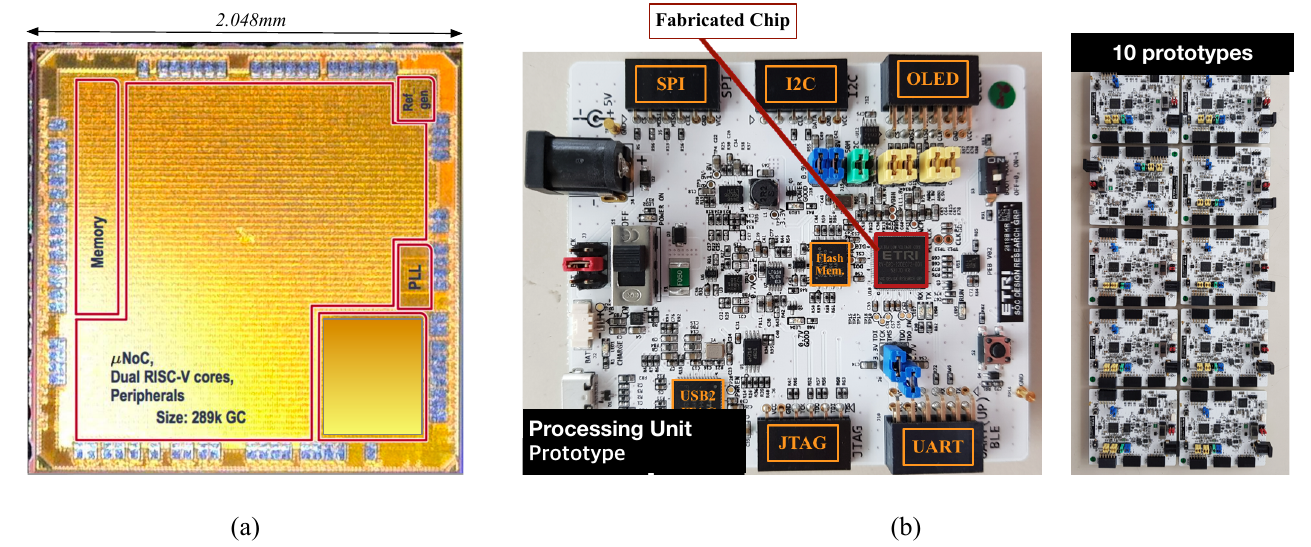
Figure 6. ( a ) Silicon Die photo of the prototyping SoC, and ( b ) the IoT device boards with the prototyping SoCs (sourced from [9]).